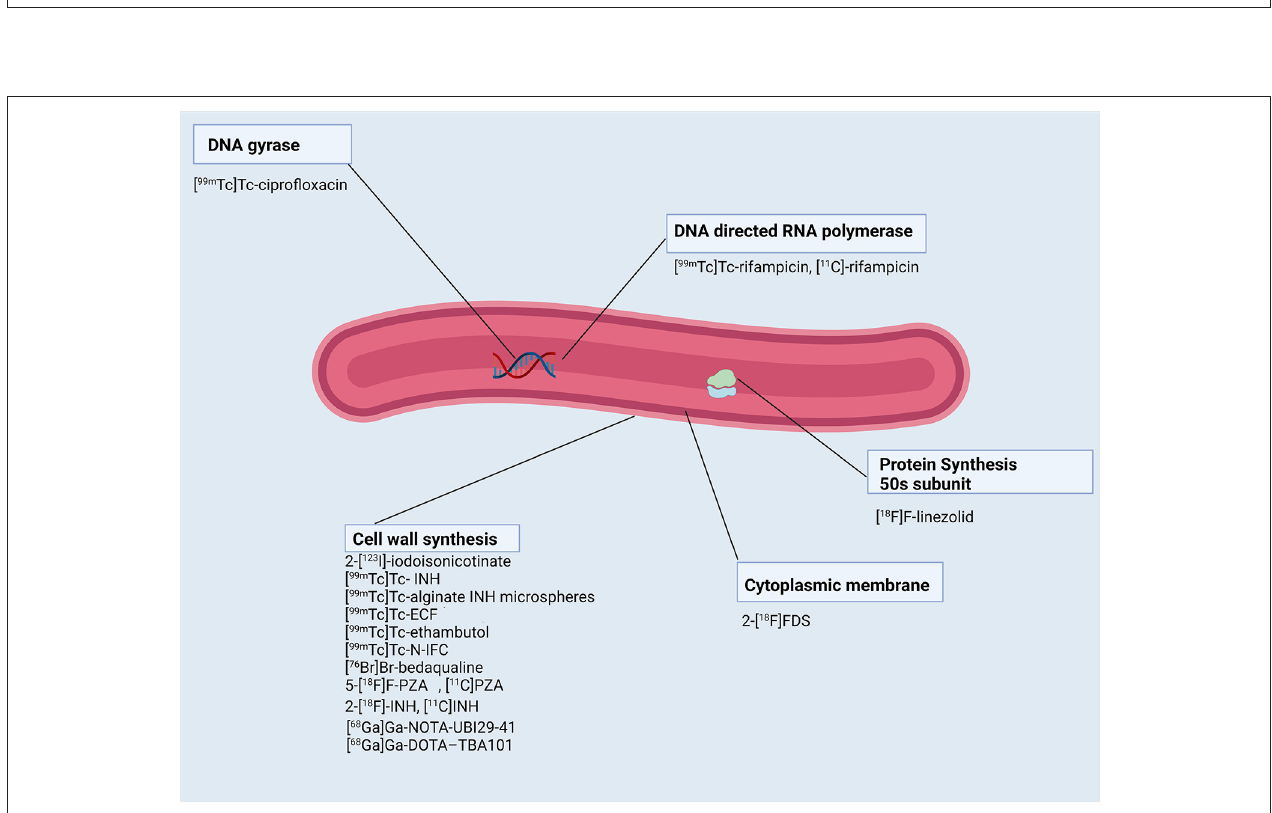
FIGURE 2 | Schematic representation of Mycobacterium tuberculosis bacillus and the radiopharmaceuticals listed according to their mechanisms of action.